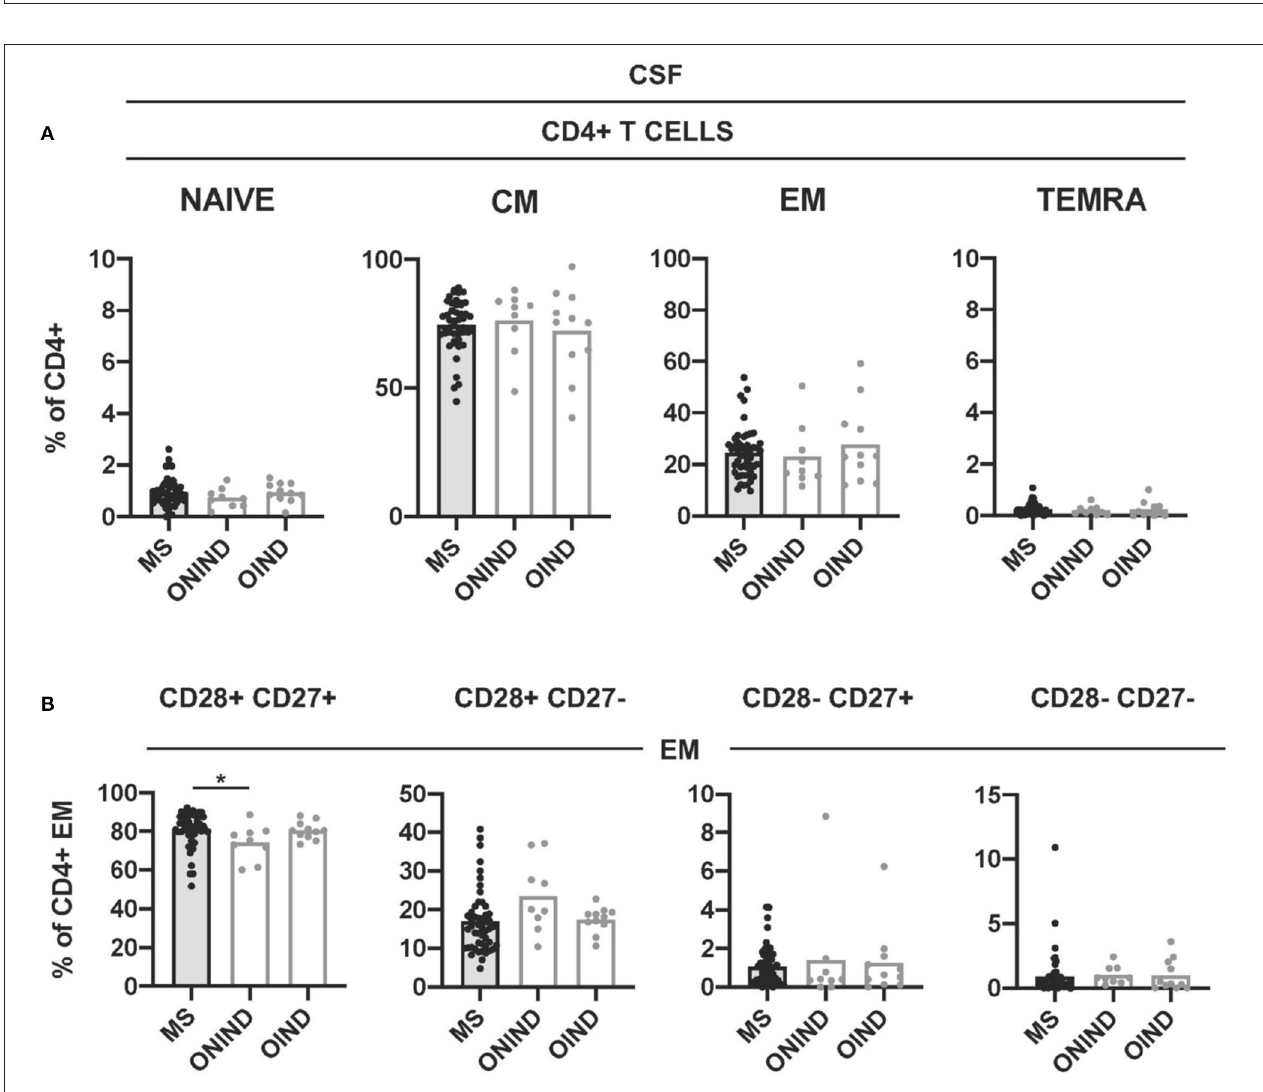
FIGURE 5 | disease (ONIND) ( n = 12) and other inflammatory neurological disease (OIND) ( n = 12). (B) Frequencies of circulating naïve-, CM-, EM-, and TEMRA CD4 + T cells in patients with MS and controls. (C) Frequencies of CD28 + CD27 + , CD28 + CD27-, CD28- CD27 + , and CD28- CD27- cells among circulating naïve-, CM-, EM-, and TEMRA CD4 + T cells from patients with MS and controls. Each dot in the graphs corresponds to a single patient and bars show means. The Kruskal–Wallis test was used to compare patients with MS and controls. Statistical significance (* p < 0.05, ** p < 0.01, *** p < 0.001, and **** p < 0.0001) is shown.